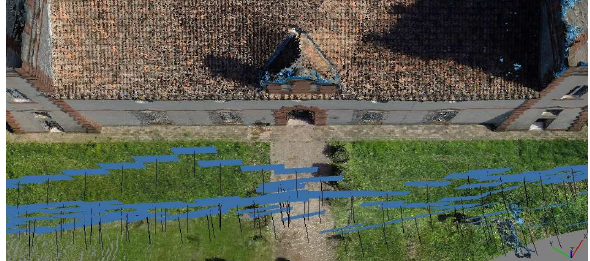
Figure 18: Point clouds and camera positions obtained using fisheye release (dataset 02)